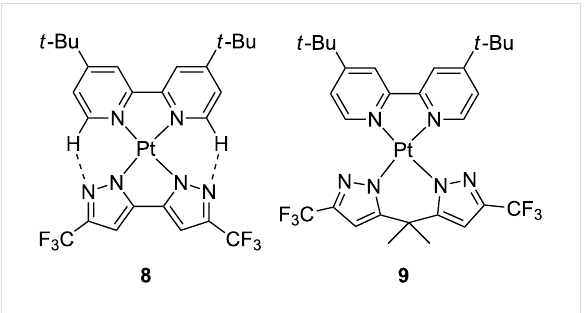
Figure 4: Selected neutral platinum(II) complexes featuring dianionic biazolate and neutral bipyridines